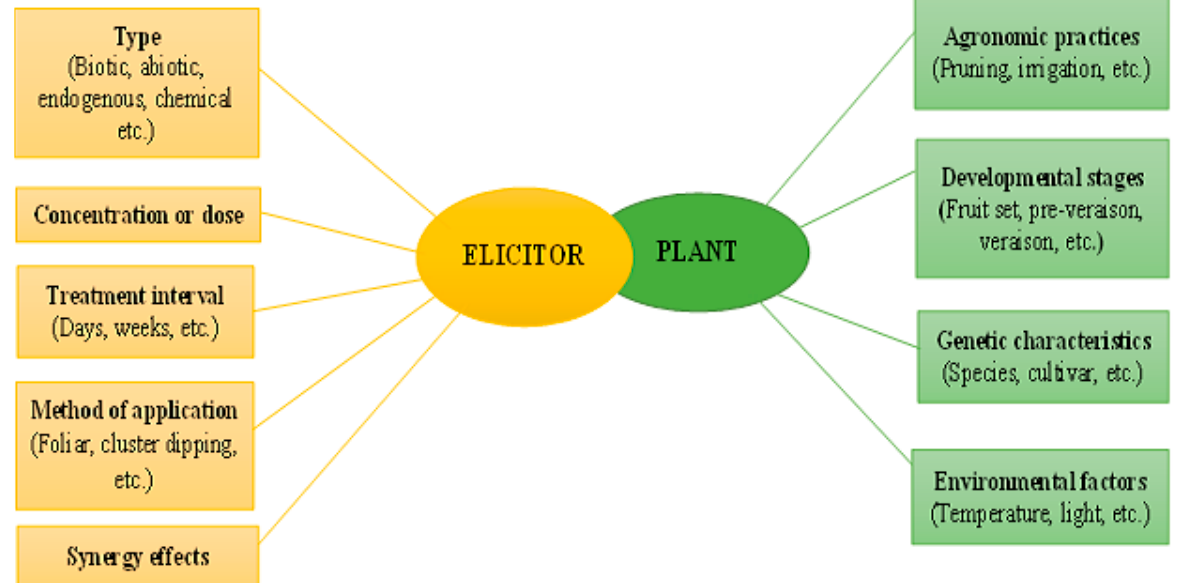
Figure 3. Factors influencing the production of secondary metabolites in plant-elicitor interactions.